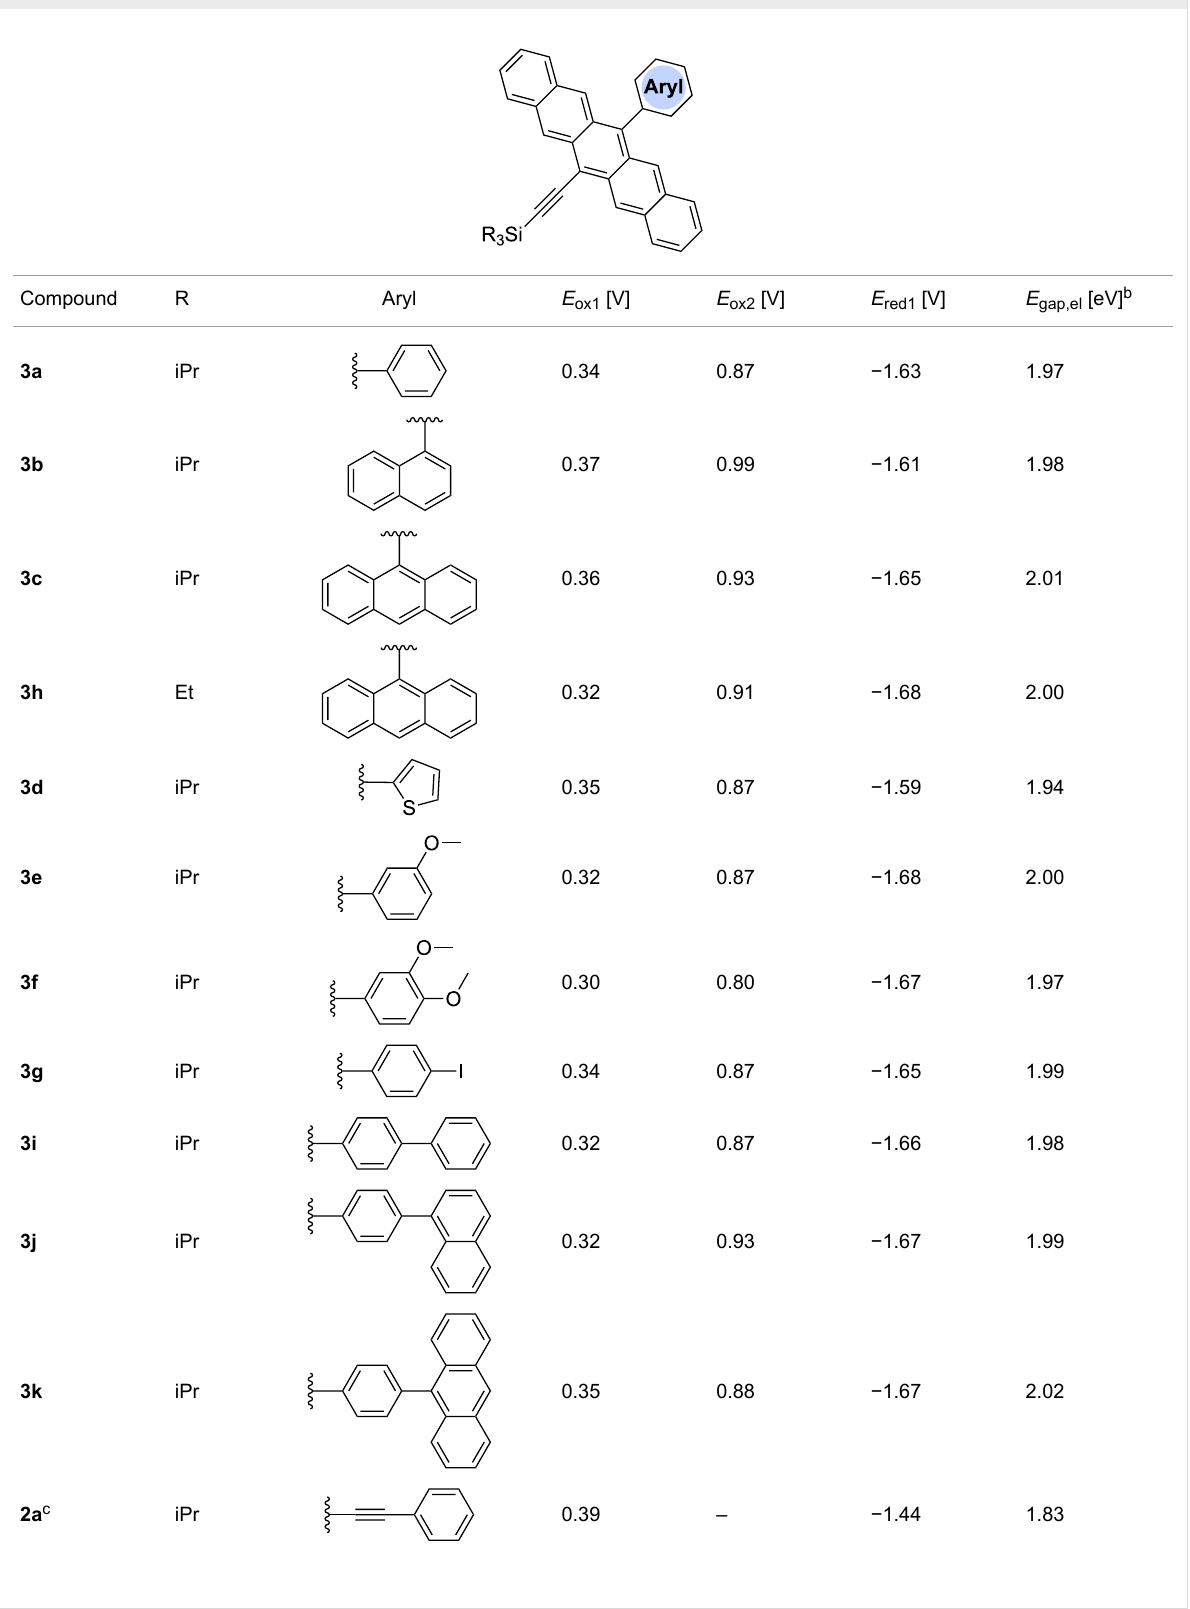
Table 3: Electrochemical properties of 3a – k compared to TIPSPc and 2a – c . a